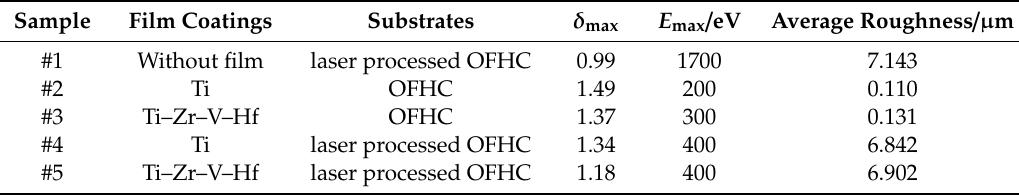
Table 1. Sample information in this